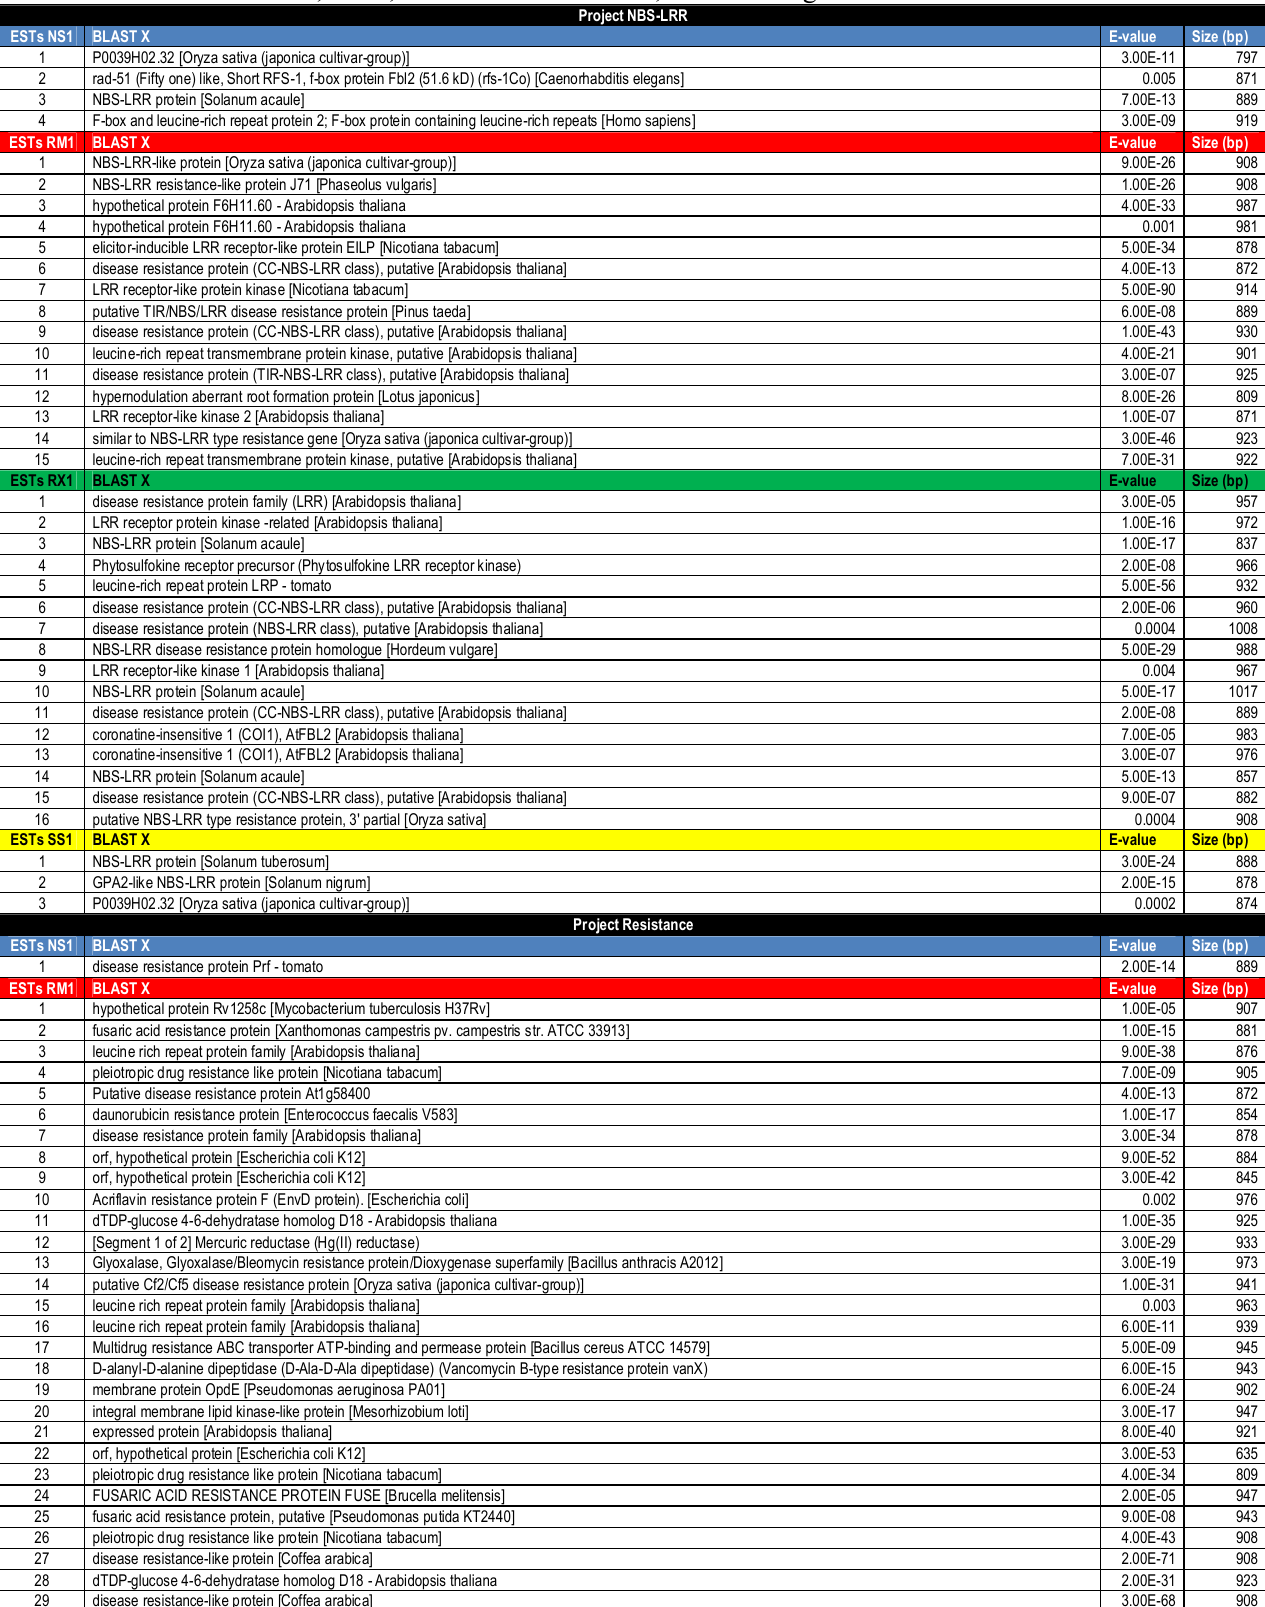
Table S15 : ESTs from NS1, RM1, RX1 and SS1 libraries, shown in Figure